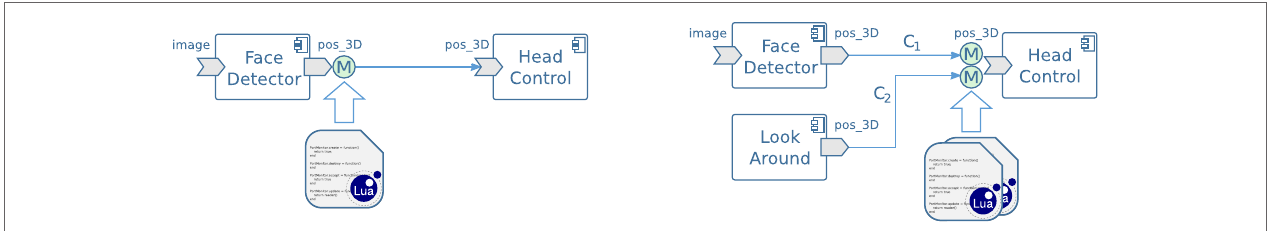
FigUre 9 | conceptual representation of Port Monitor (left) and its use for arbitration (right) . Left: the output Port of Face-Detector is extended with a plug-in, which provides access to the outgoing data through scripting language (e.g., Lua). Right: at the input Port , the Port Monitor can arbitrate data from